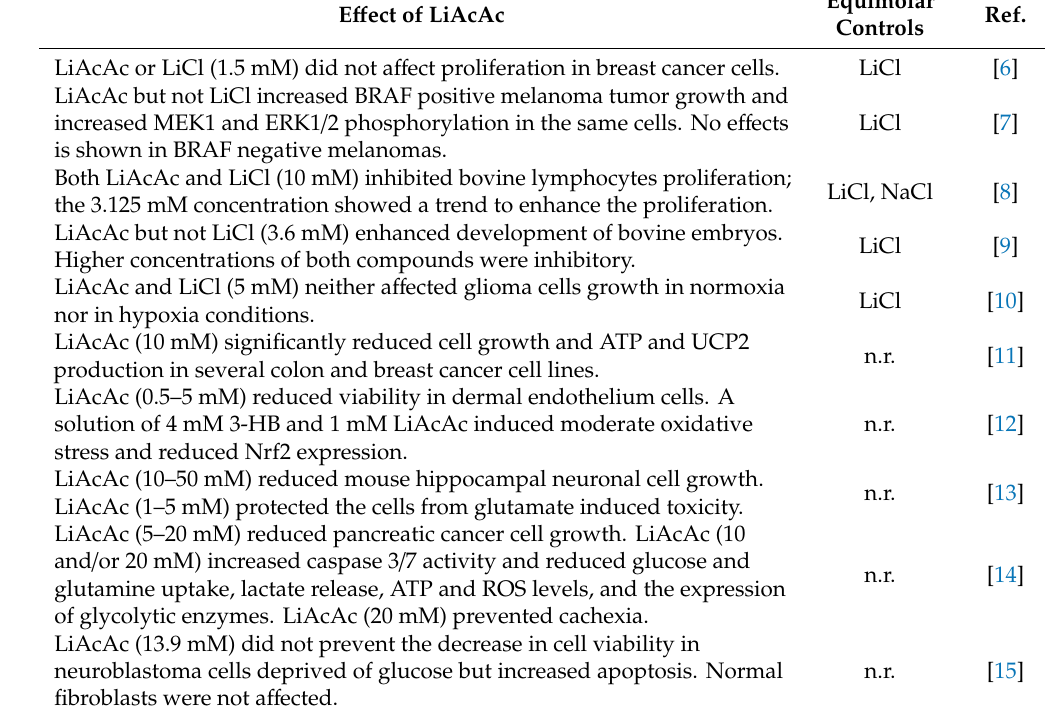
Table 1. In vitro and in vivo studies investigating the e ff ects of LiAcAc on cell proliferation, tumor growth, and cancer metabolism. Equimolar Ref. E ff ect of LiAcAc Controls LiAcAc or LiCl (1.5 mM) did not a ff ect proliferation in breast cancer cells. LiCl [6] LiAcAc but not LiCl increased BRAF positive melanoma tumor growth and increased MEK1 and ERK1 / 2 phosphorylation in the same cells. No e ff ects LiCl [7] Both LiAcAc and LiCl (10 mM) inhibited bovine lymphocytes proliferation; LiCl, NaCl [8] LiAcAc but not LiCl (3.6 mM) enhanced development of bovine embryos. LiCl [9] LiAcAc and LiCl (5 mM) neither a ff ected glioma cells growth in normoxia LiCl [10] LiAcAc (10 mM) significantly reduced cell growth and ATP and UCP2 n.r. [11] LiAcAc (0.5–5 mM) reduced viability in dermal endothelium cells. A solution of 4 mM 3-HB and 1 mM LiAcAc induced moderate oxidative n.r. [12] LiAcAc (10–50 mM) reduced mouse hippocampal neuronal cell growth. n.r. [13] LiAcAc (1–5 mM) protected the cells from glutamate induced toxicity. LiAcAc (5–20 mM) reduced pancreatic cancer cell growth. LiAcAc (10 and / or 20 mM) increased caspase 3 / 7 activity and reduced glucose and glutamine uptake, lactate release, ATP and ROS levels, and the expression LiAcAc (13.9 mM) did not prevent the decrease in cell viability in neuroblastoma cells deprived of glucose but increased apoptosis.